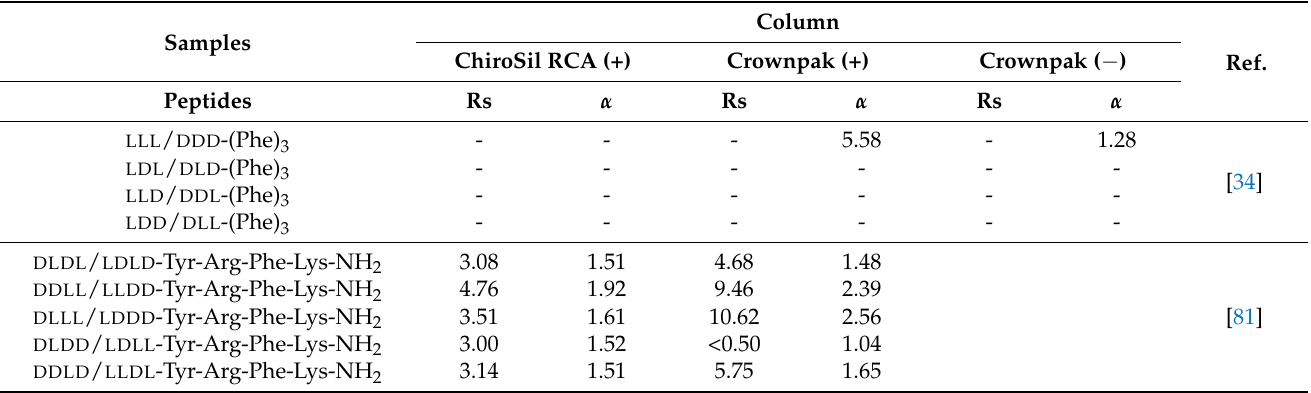
Table 4. Comparison of peptide separation performances using the ChiroSil RCA (+), Crownpak (+) and Chrownpak ( − )